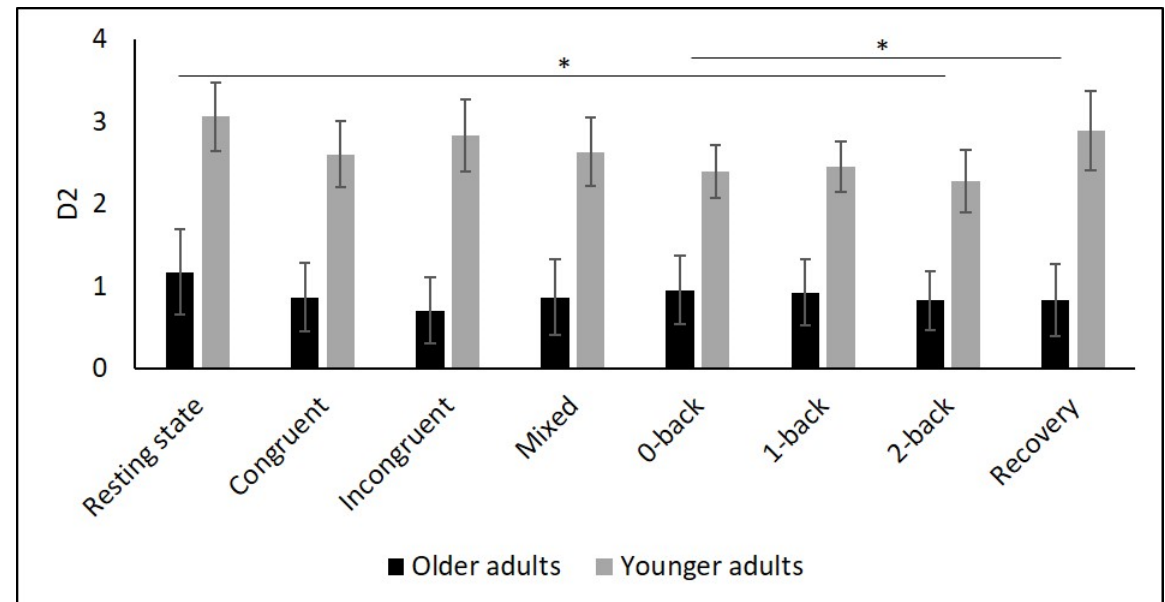
Figure 5. Means and group × condition interactions for HF. Error bars indicate ±2 standard error of mean; abbreviations: HF: high frequency; ms: milliseconds. * p < 0.05.